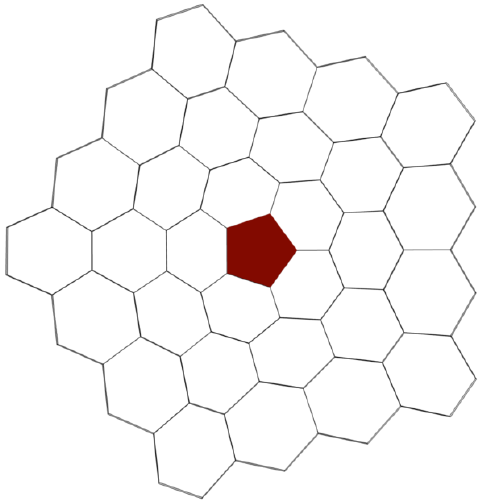
Figure 7: Wedge disclination in a graphene-like structure. At the centre of the discli- nation a 5-ring has been inserted. The 6-fold symmetry is hereby becoming globally